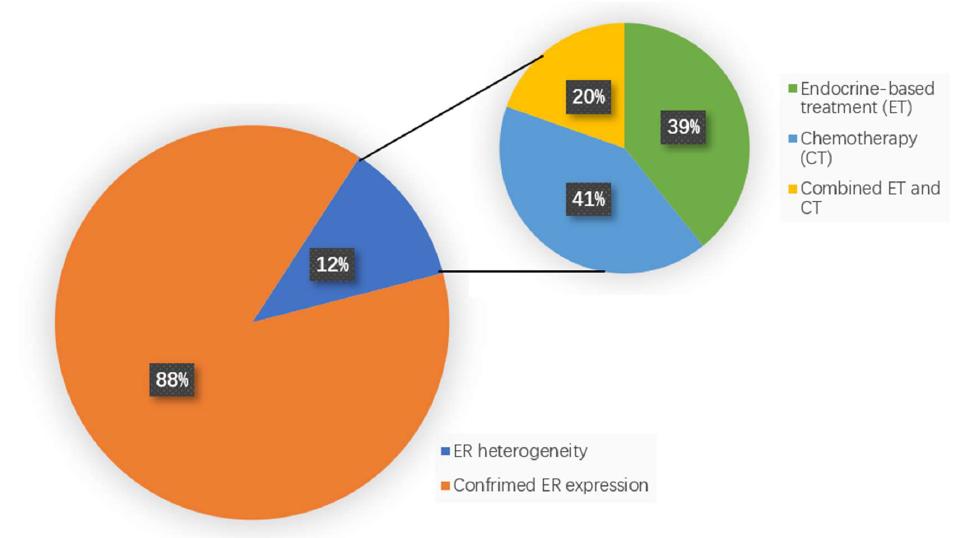
Figure 1. Incidence and treatment pattern of patients with ER heterogeneity.